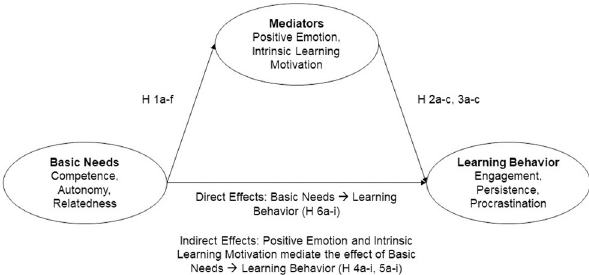
Fig 1. Overview of the assumed relations (direct and indirect effects) in this study.